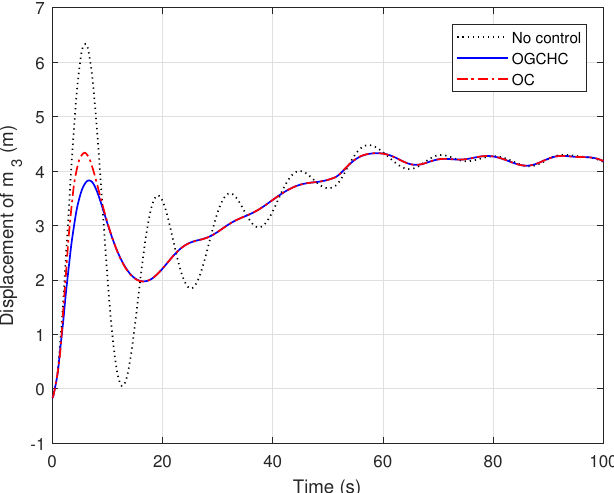
Figure 5. Displacement 3 of the riser without control, with OC and OGCHC under case I.